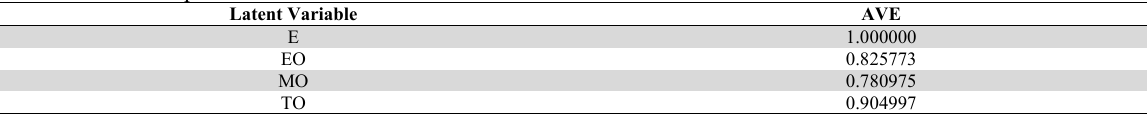
Results of AVE recapitulation